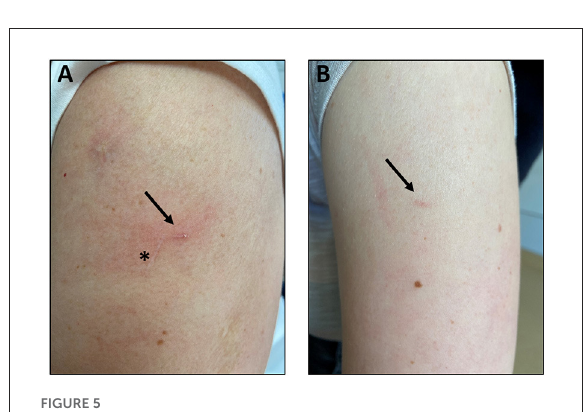
FIGURE5 Scars (arrows) of two individual participants (A) 91 days and (B) 89 days after self-sampling. Asterisk to clarify diagonal previous unrelated